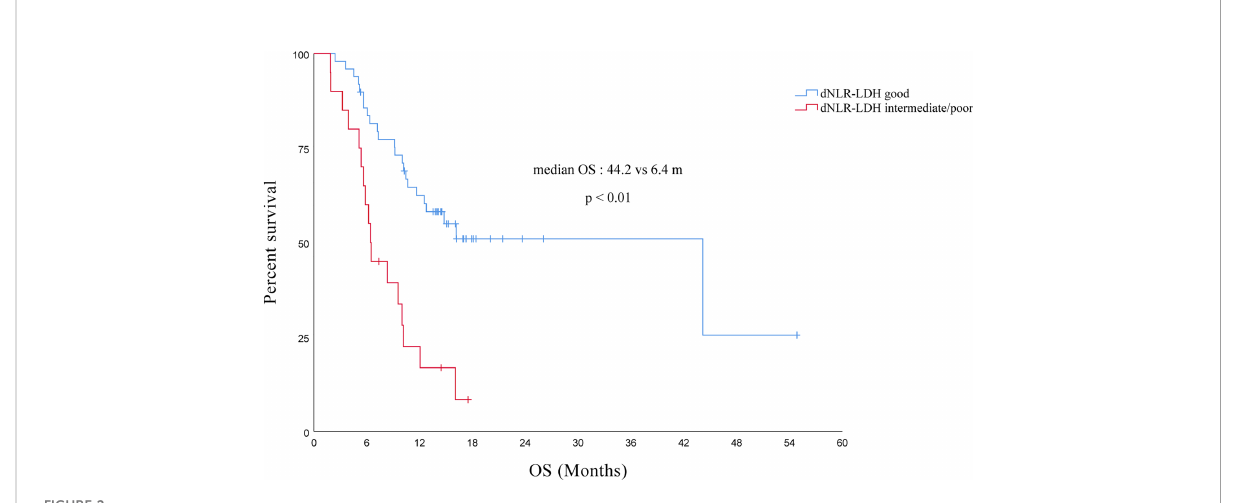
FIGURE 2 Association between pretreatment dNLR-LDH indicator with OS.